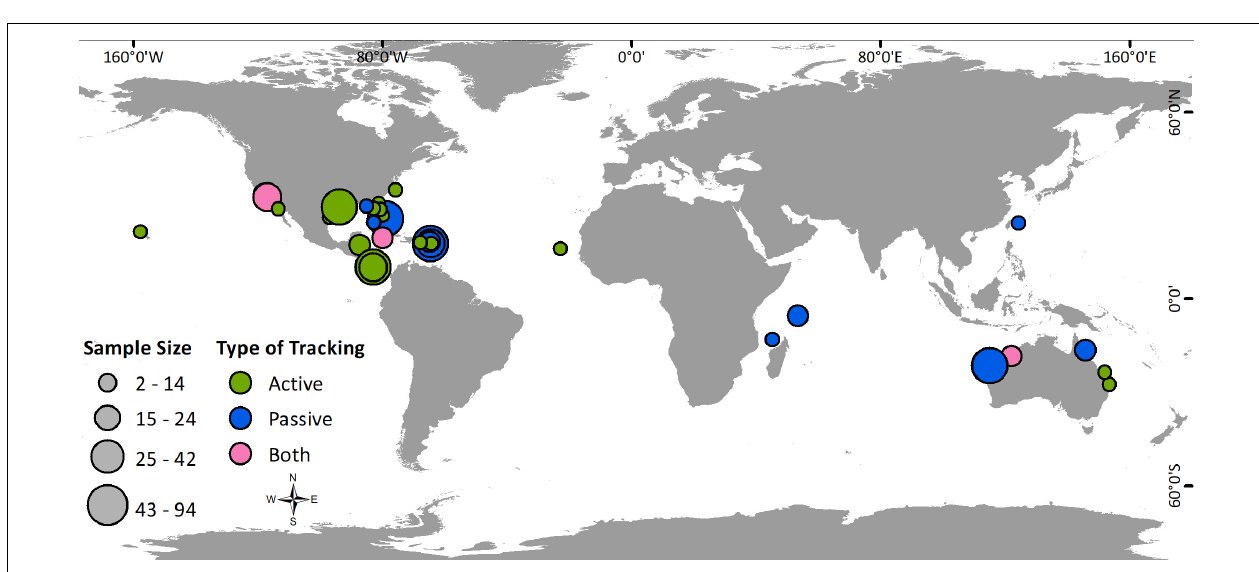
FIGURE 1 | Number of acoustic telemetry studies published per year utilizing active tracking (black), passive tracking (gray), or both types of tracking (white). Cumulative number of studies shown by dotted line. ∗ Data from 2021 only includes studies published prior to January 28th and therefore is not comparable to other